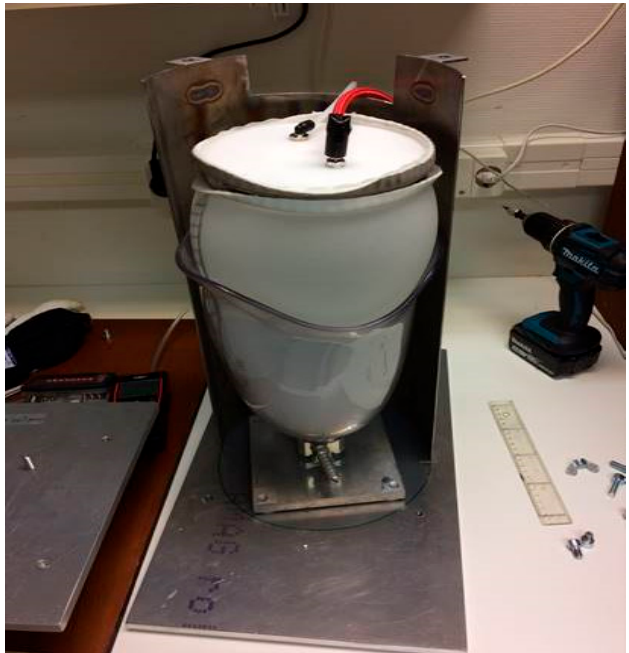
Figure 15. The liner balloon test setup on the base.